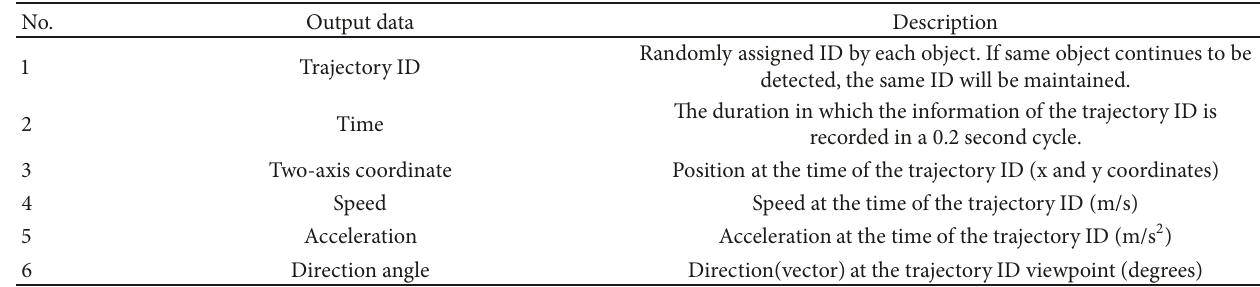
Table 1: Collected data list and descriptions for pedestrian trajectory